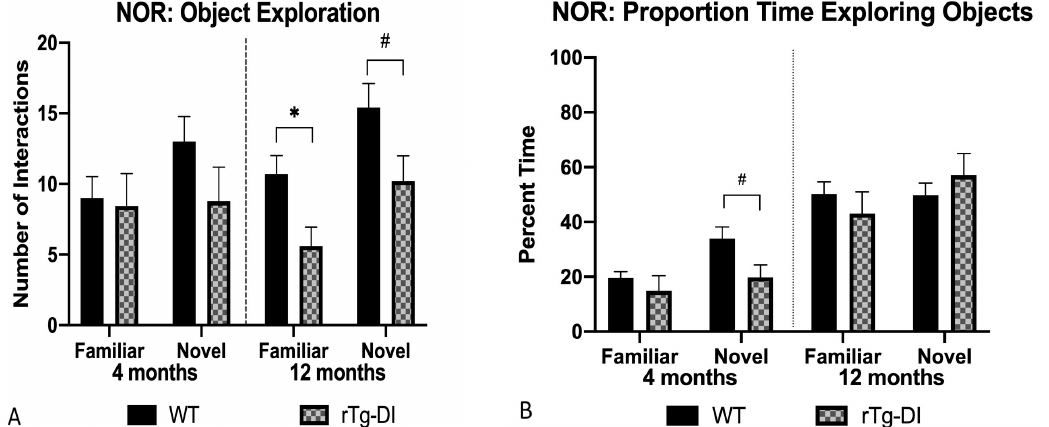
Figure 10. Novel object recognition. ( A ) rTg-DI rats had fewer interactions at 12 months with both the familiar and novel objects than WT. ( B ) rTg-DI spent a smaller proportion of time interacting with the novel object at 4- but not 12-months than WT rats. # p < 0.05 , * p < 0.01 . Data represent mean + SEM.